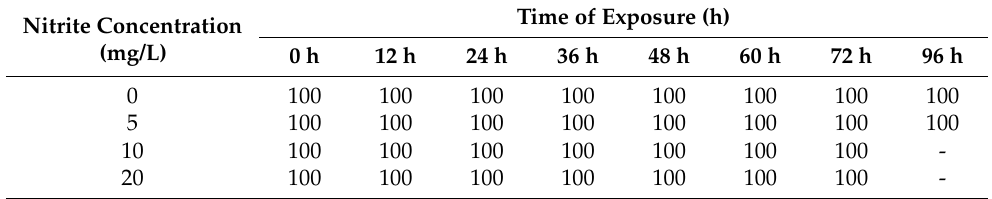
Table 2. Changes in survival rates (%) of pearl gentian grouper exposed to various nitrite concentrations. Nitrite Concentration